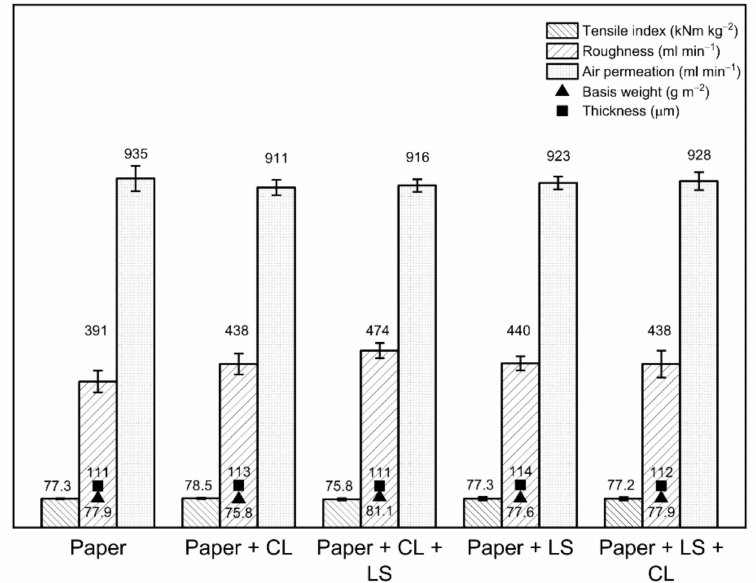
Figure 8. Tensile index, roughness, air permeability, basis weight, and thickness of the papers coated with: one layer of cationic lignin (CL); first layer of CL and second layer of lignosulfonates (CL + LS); one layer of LS and first layer of LS and second layer of